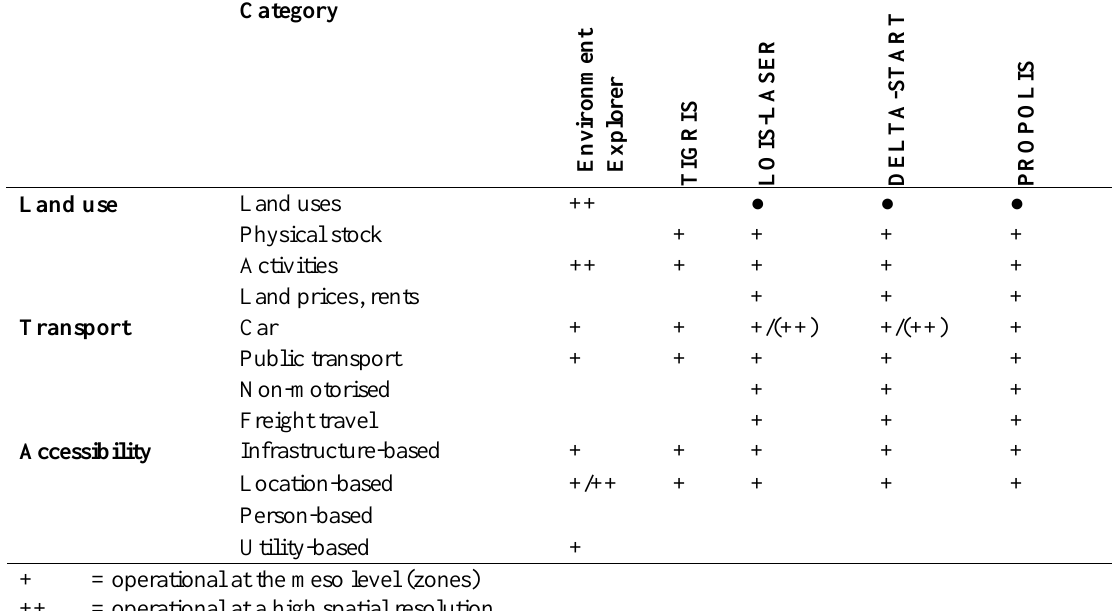
Table 2: Overview of intermediate indicators in selected LUTI